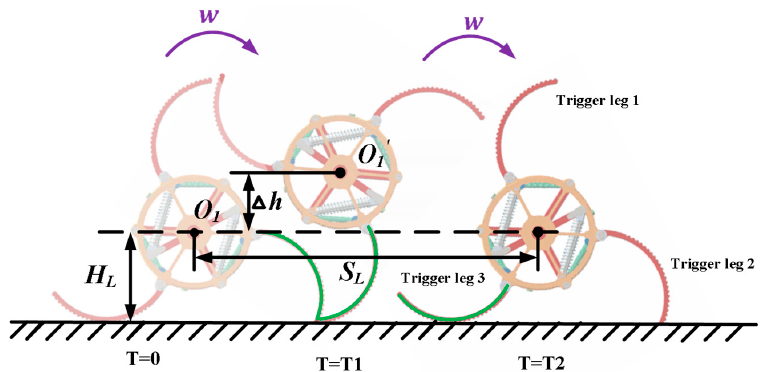
Figure 7. Wheel change process in one cycle.